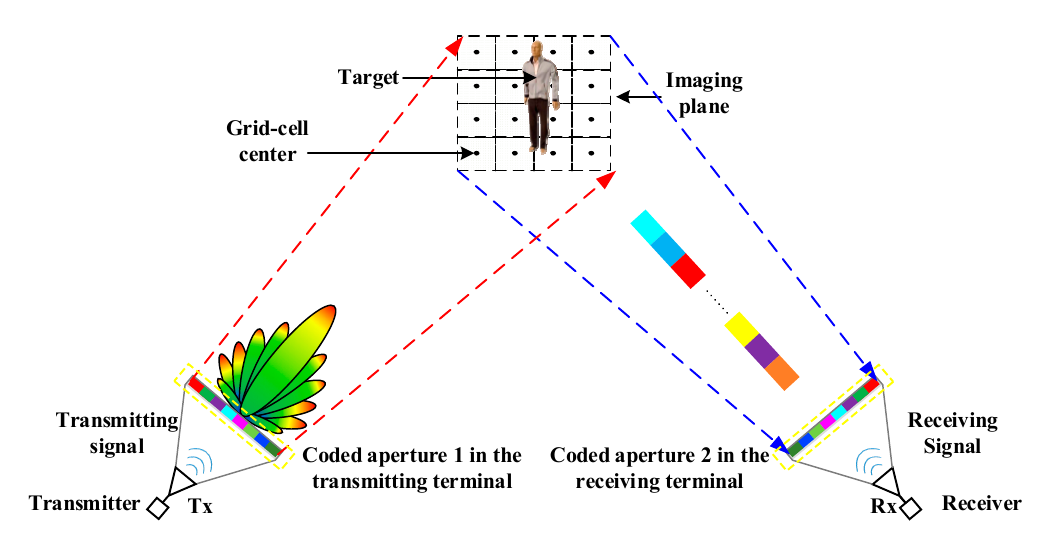
Figure 1. Schematic diagram of the terahertz coded-aperture imaging (TCAI) system.